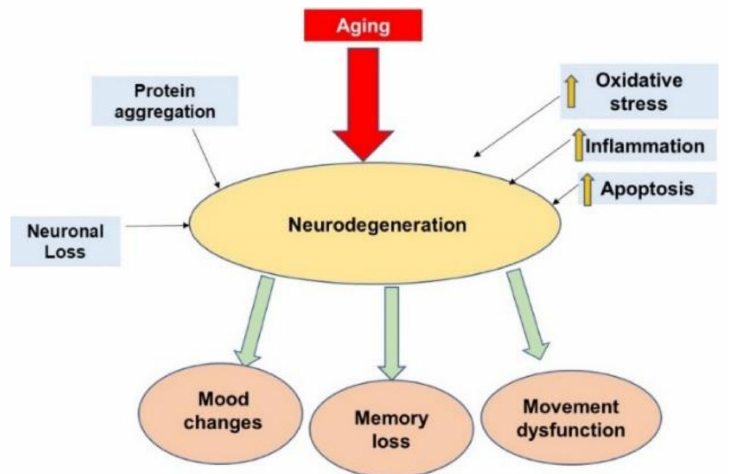
Figure 2. Common factors that induce neurodegeneration. Aging is one of the main factors associated with neurodegeneration, leading to changes in mood, memory loss, and movement dysfunction. Moreover, protein aggregation, neuronal loss, inflammation, oxidative stress, and apoptosis may also promote neuronal death. Yellow arrows indicate an